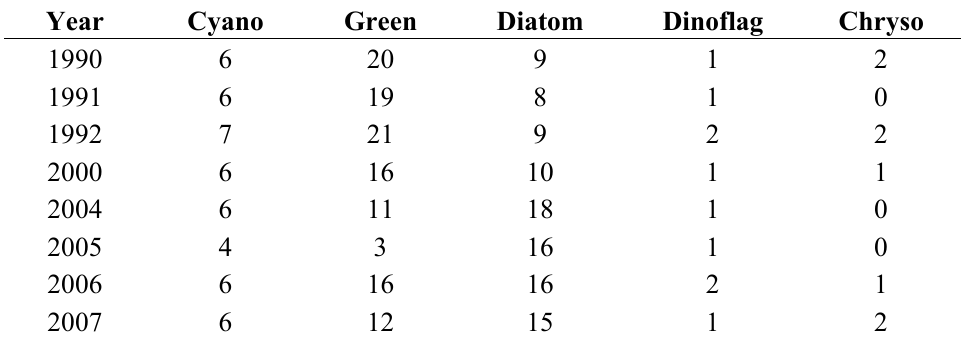
Table 3. Total number of phytoplankton genera observed throughout the year ( i.e. , genus-level richness) for major taxonomic groups at inner bay sites in Green Bay. Post- invasion years were